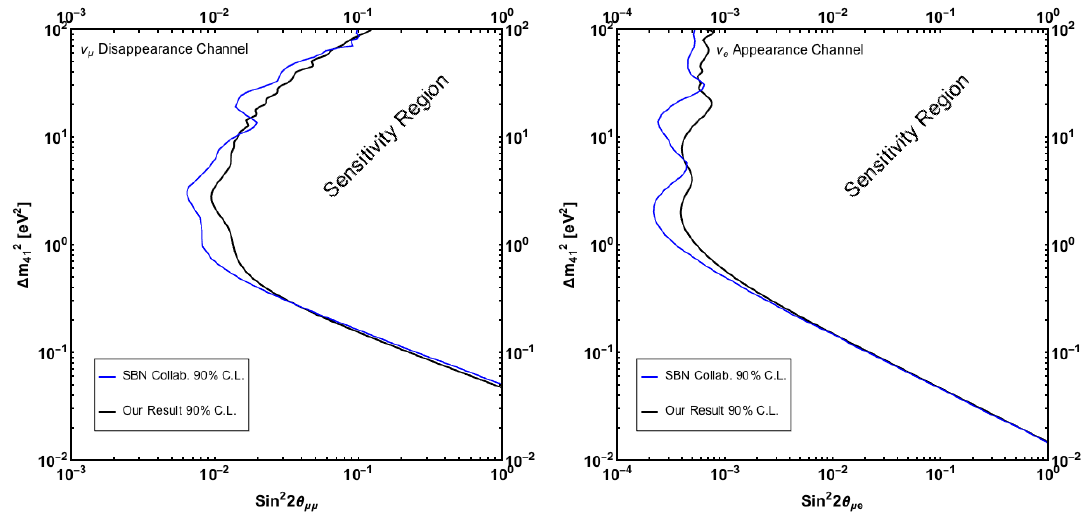
Figure 4 . Left (Right) panel: sensitivity limit at 90% of C.L. for the 3+1 model for the muon neutrino disappearance channel (electron neutrino appearance channel), in the parameter space which depends on sin 2 2 (cid:18) (cid:22)(cid:22) (sin 2 2 (cid:18) (cid:22)e ) and (cid:1) m 2 . Exclusion (sensitivity) regions are to top-right 41 of the black dashed curves in both panels. The solid black curve (solid blue curve) shows our sensitivity (the SBN sensitivity was taken from ref.